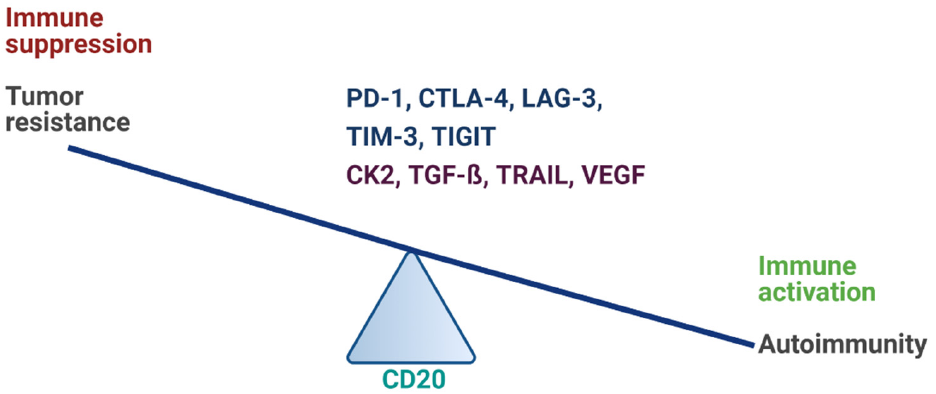
Figure 1. Classical and nonclassical immune modulators in malignant glioma and autoimmune diseases. A careful balance should be maintained when targeting immune modulators in therapeutic efforts, whereas B-cell-depleting immunotherapy (by CD20 blockade) may be beneficial in both malignant glioma and autoimmune diseases. Classical molecules (blue)—PD-1: programmed cell death protein-1, CTLA-4: cytotoxic T-lymphocyte antigen 4, LAG-3: lymphocyte-activation gene 3, TIM-3: T-cell immunoglobulin and mucin-domain containing-3, TIGIT: T cell immunoreceptor with Ig and ITIM domains. Nonclassical molecules (purple)—CK2: casein kinase 2, TGF- β : transforming growth factor beta, TRAIL: tumor necrosis factor-related apoptosis-inducing ligand, VEGF: vascular endothelial growth factor, CD20: cluster of differentiation 20 (B-lymphocyte antigen). Figure created with BioRender.com (accessed on 28 May 2021).